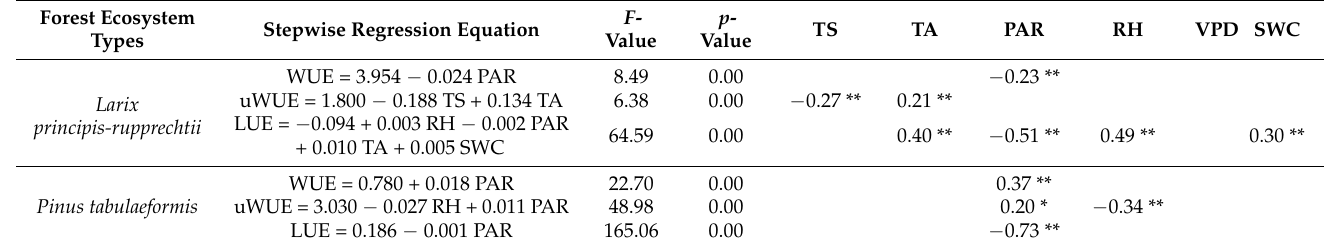
Table 2. Results for the multiple stepwise regression analysis of effects of potential meteorological drivers (TS, TA, PAR, RH, VPD, and SWC) on the water use efficiency (WUE), underlying water use efficiency (uWUE), and light use efficiency (LUE) in two forest ecosystems during growing